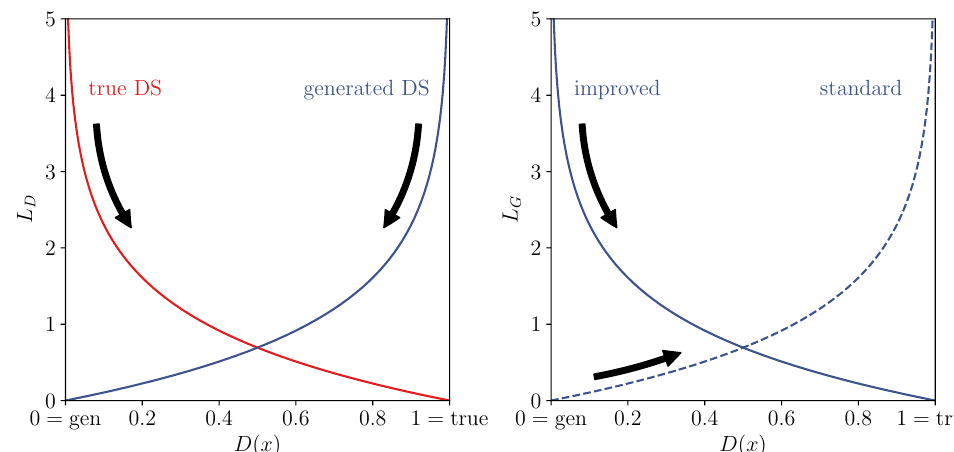
Figure 2: Discriminator and generator losses as a function of the value assigned by the discriminator. The red line indicates batches from the true distribution, the blue lines batches from a generated distribution. The arrows indicate the direction of the